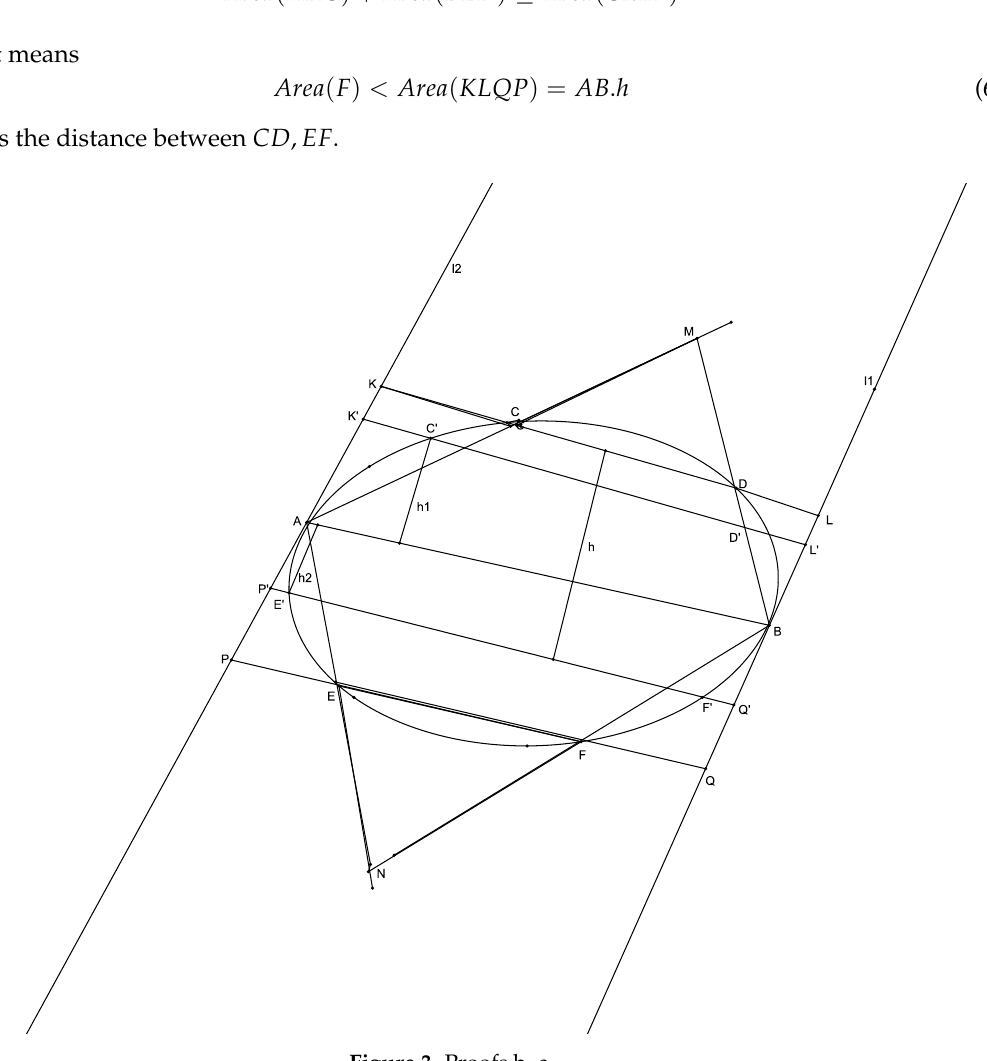
Figure 3. Proofs b,